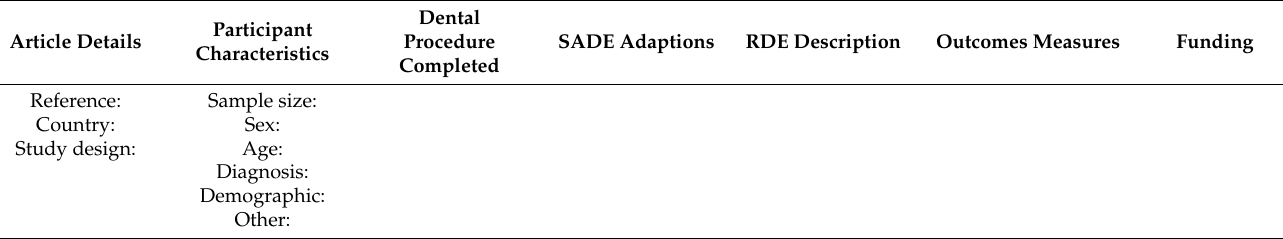
Table A1. Characteristics of included studies.